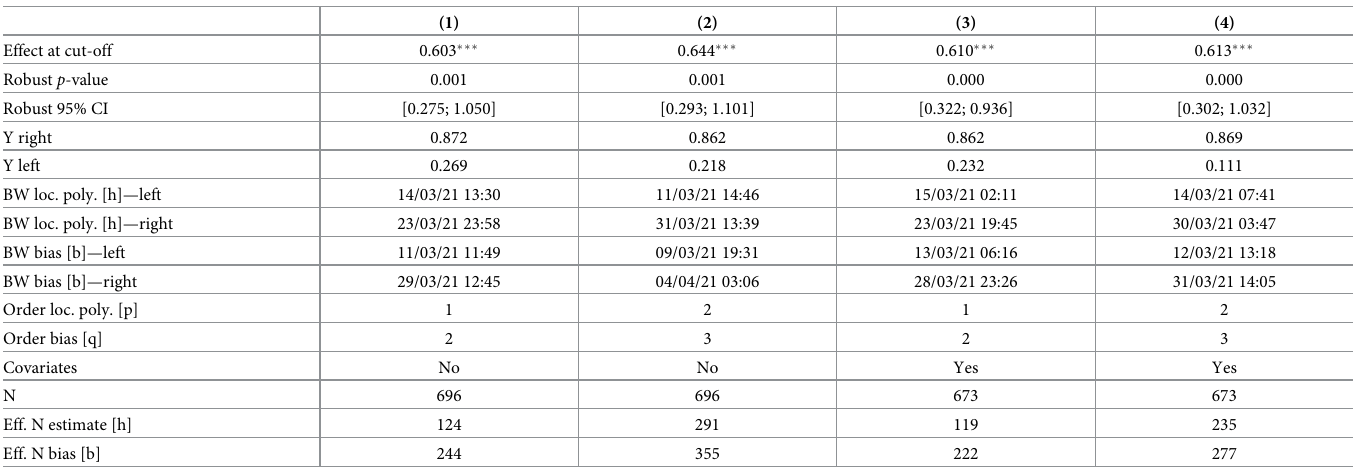
Table 5. RDD estimates using time at the beginning of the survey as running variable.